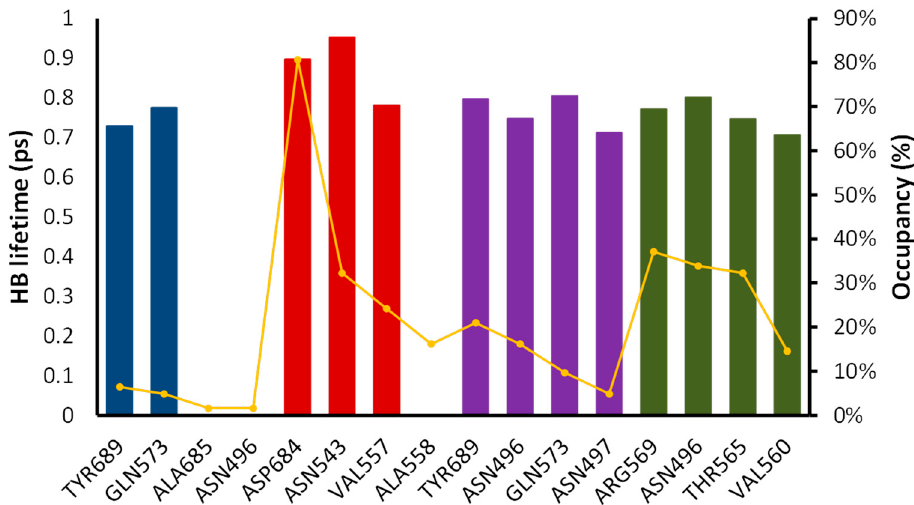
Figure 12. Occupancy (yellow lines) and hydrogen bond (HB) lifetimes (bars) for the MD results of RdRp. Chloroquine in blue, digoxin in red, dronedarone in purple, and remdesivir in green. Based on the highest occupancy and HB lifetimes, two key residues were chosen for the interaction of RdRp with each of the four ligands. Then, the distances between the